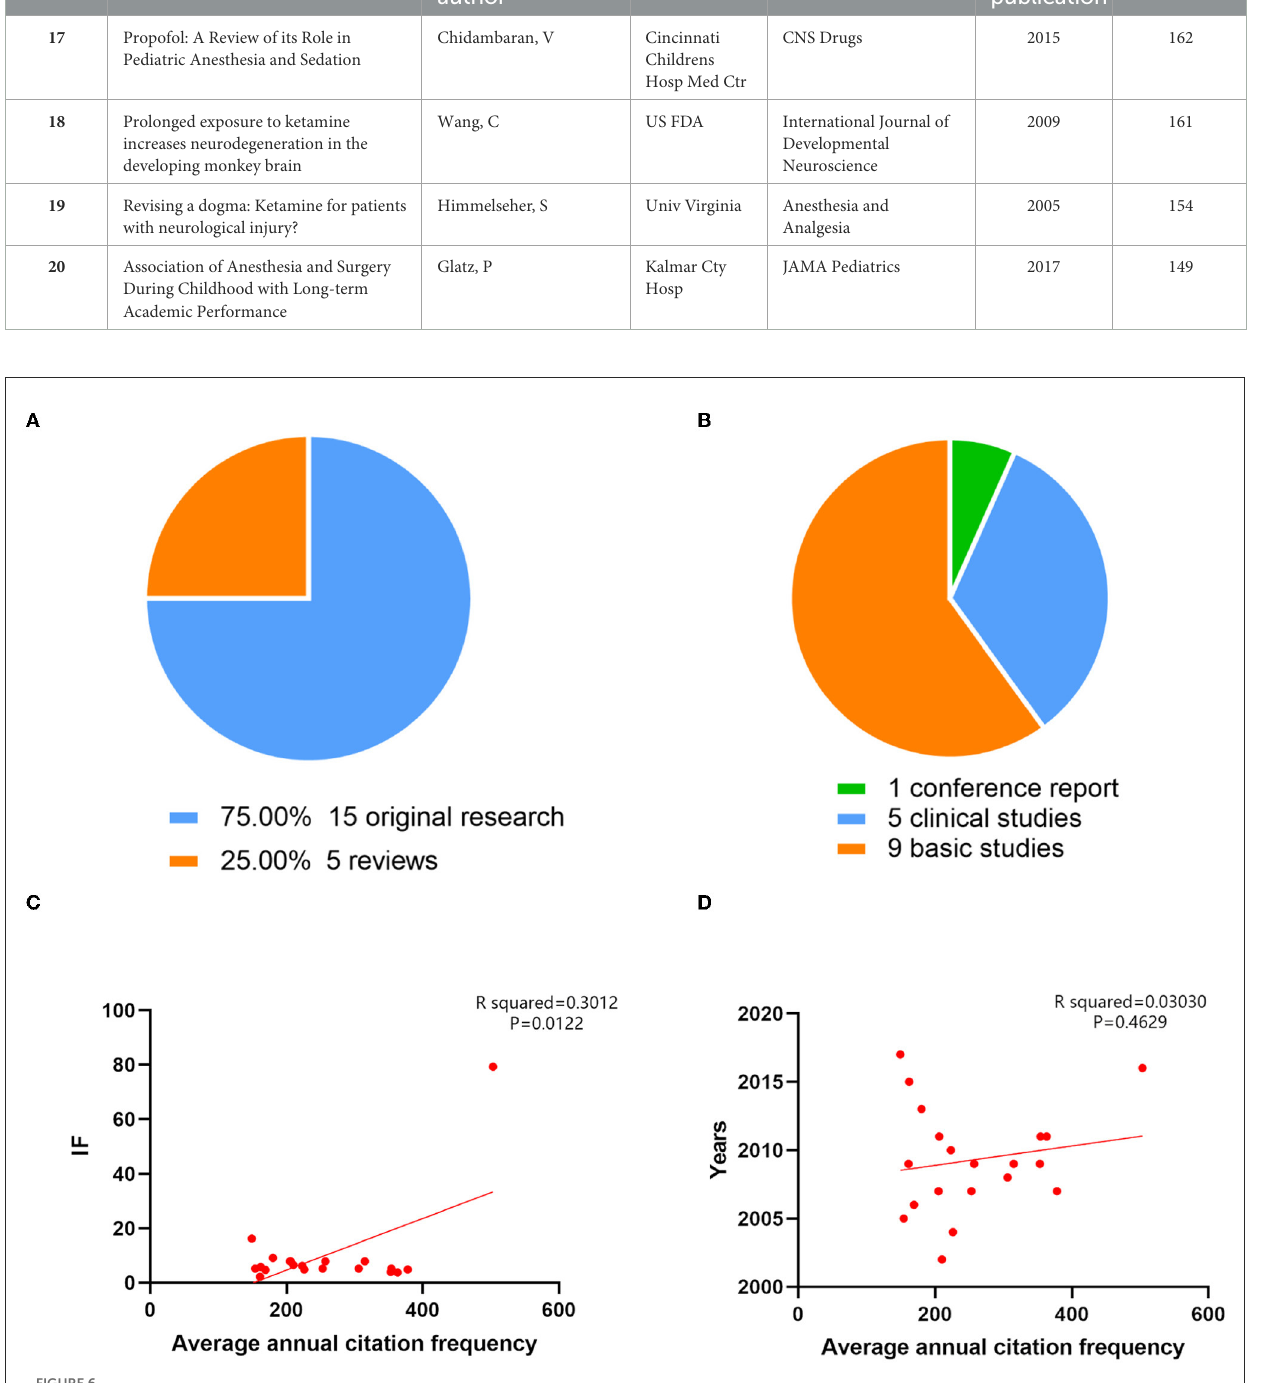
rapid onset of action and the fact that it is currently the